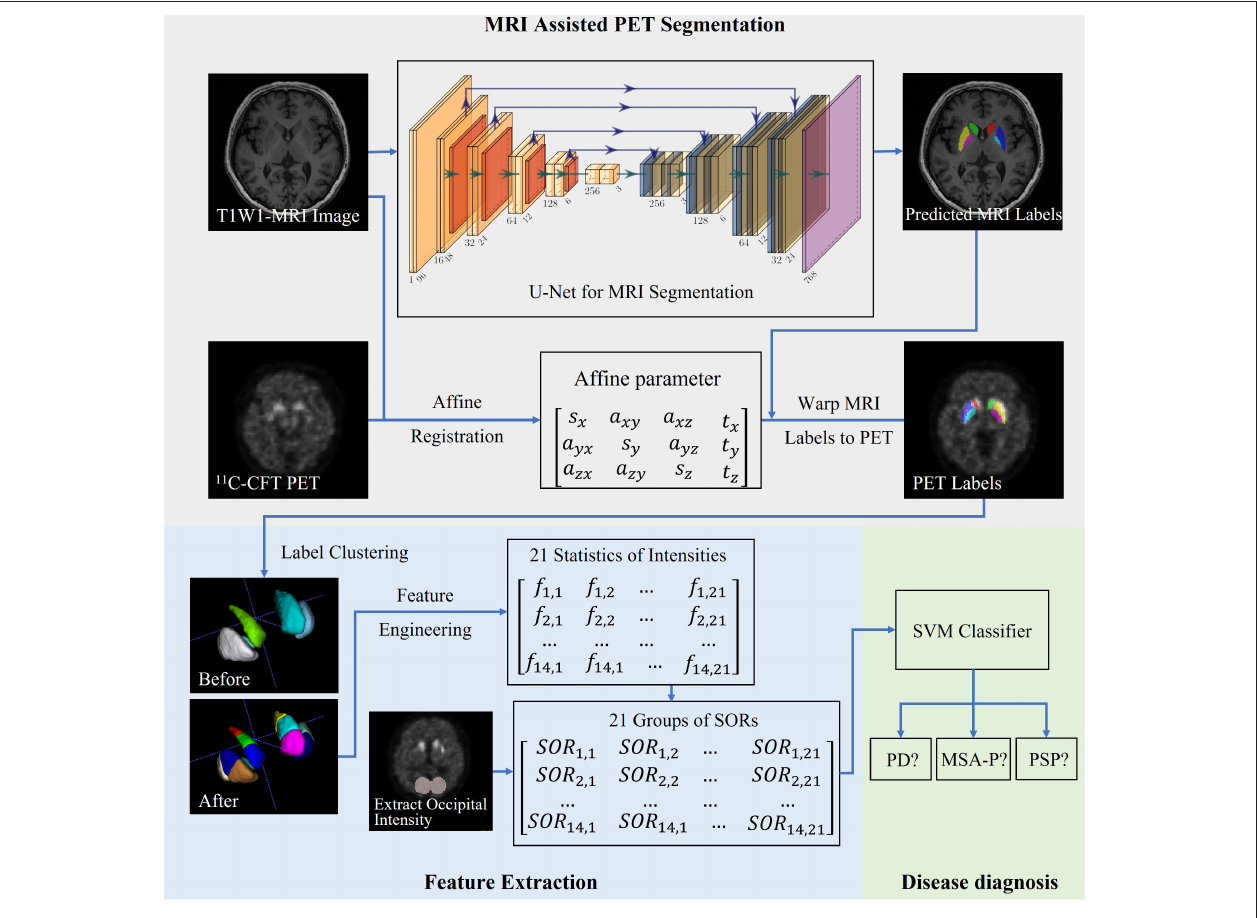
FIGURE 1 | Visual representation of the proposed computer-aided classification framework. Magnetic resonance imaging (MRI)-assisted 11 C-CFT PET segmentation was followed by feature extraction and prediction. The final step consisted of automatic subject classification in each of the three diagnostic groups (PD, MSA, and